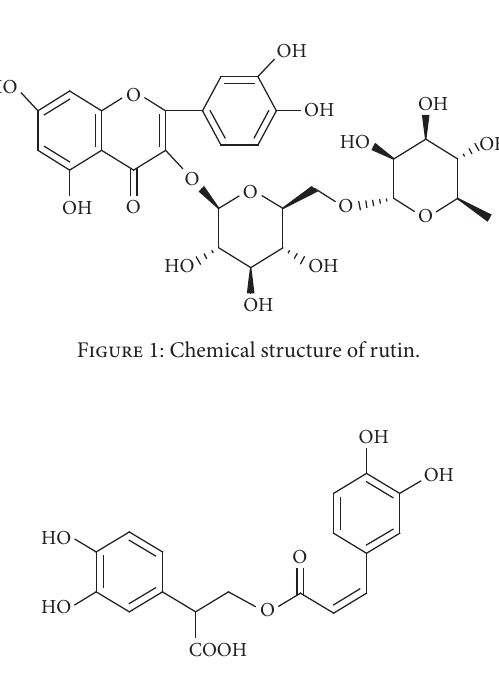
F 2: Chemical structure of rosmarinic